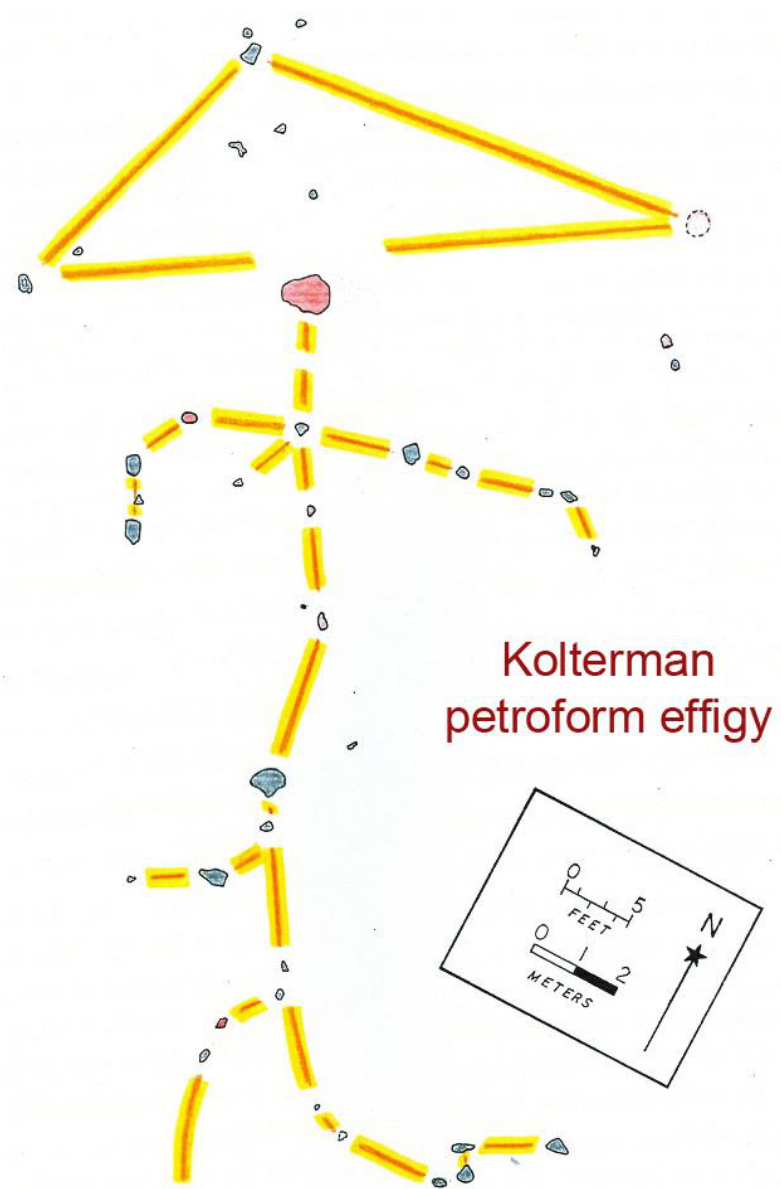
Figure 21. Map of the Kolterman Star-Being, a male, human-like lithic effigy with a serpentine body and red- coloured, bison-shaped